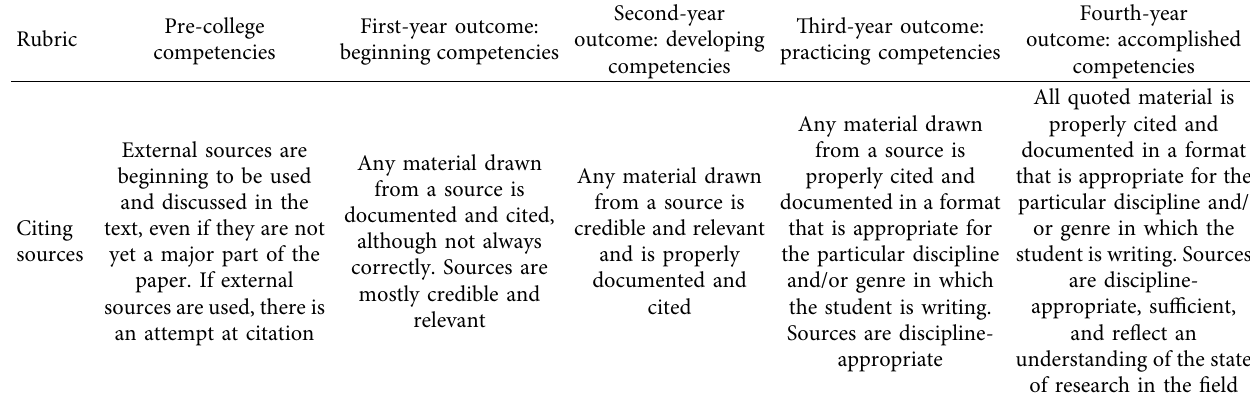
Table 1: Scoring rubric for writing assessment.